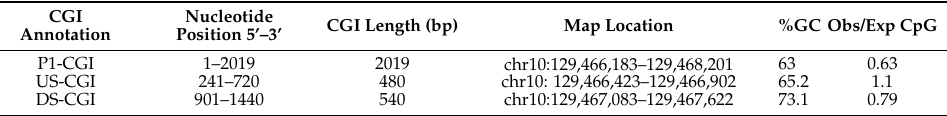
Table 2. Distribution of CpG islands (CGI) and GC content in revised MGMT exon-1 promoter (P1-CGI). US and DS refer to upstream and downstream sequences respectively. The CTCF binding sequence and TSS are located in DS-CGI.